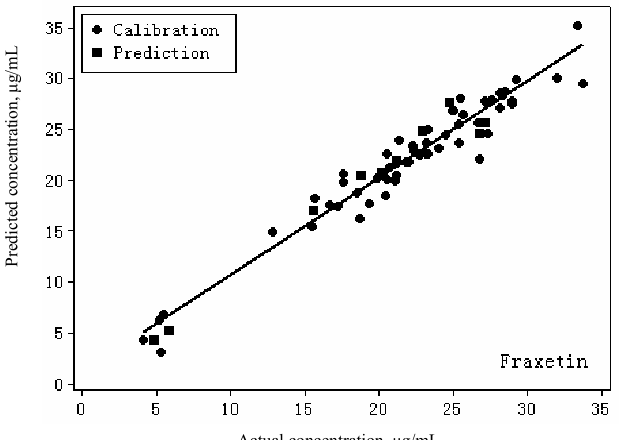
Figure 6. Correlation diagrams between the predicted values and the reference values of concentrations